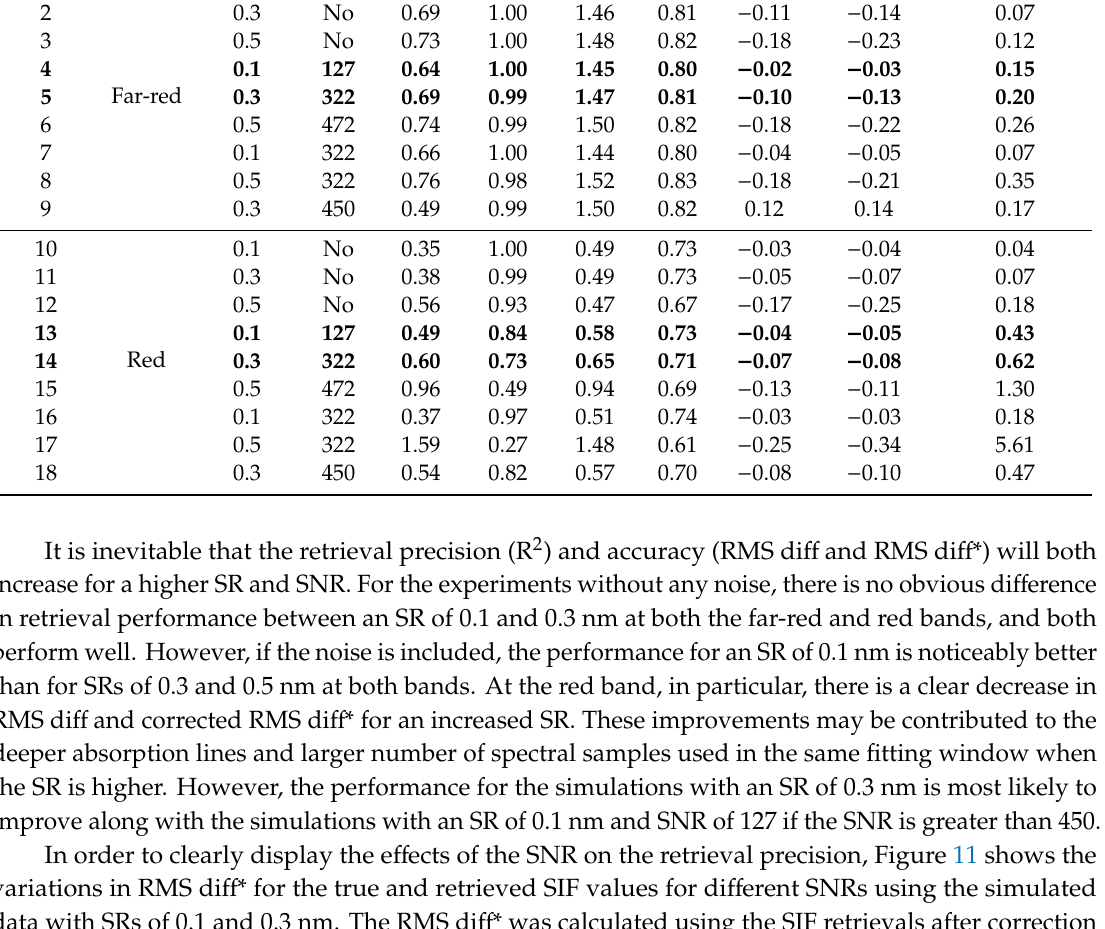
and red bands were again obtained using the fitting windows and retrieval method described above. Table 5 lists comprehensive results of the true and retrieved SIF values at both the far-red (line 1 to 9) and red bands (line 10 to 18). Statistical results for the comparisons using the simulations with di ff erent combinations of SR and SNR are also listed in Table 5. Lines 4, 5, and 6 show retrieval statistics for the far-red band based on three simulations: An SR of 0.1 nm and SNR of 127, an SR of 0.3 nm and SNR of 322, and an SR of 0.5 nm and SNR of 472. For the second case, the retrieval accuracy is rather low at